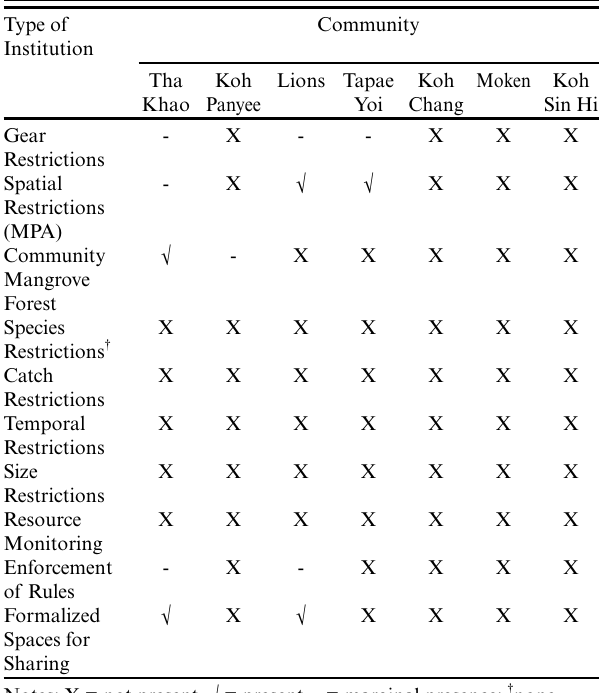
Table 3 . Presence or absence of local institutions to support conservation across the research